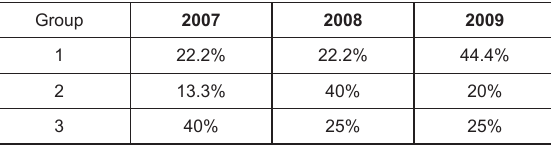
Table 2. Percent of infected animals by